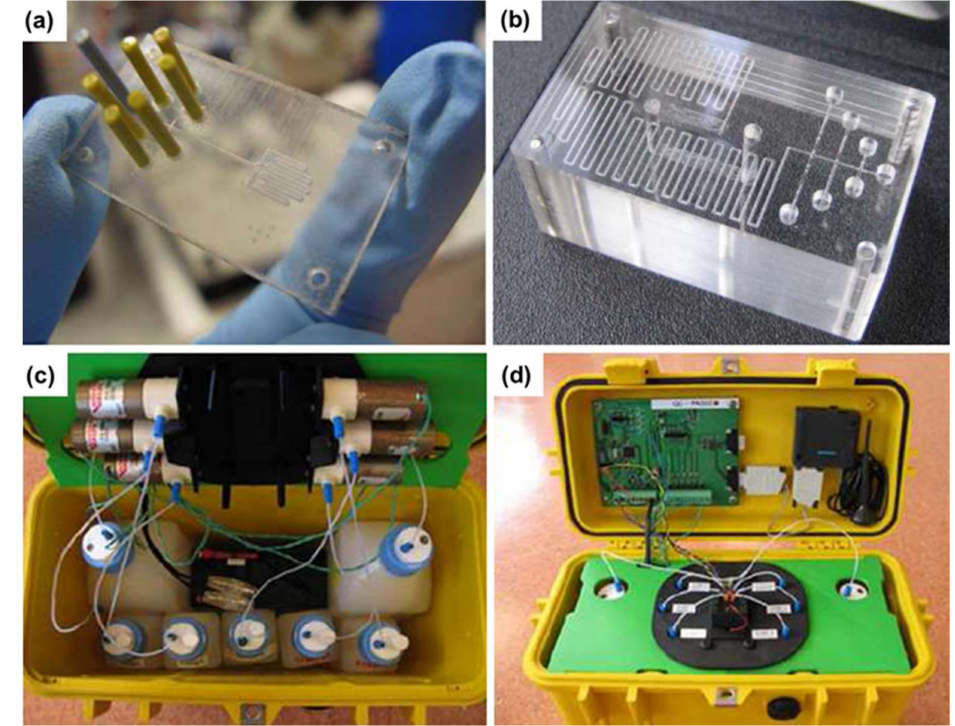
Figure 2. The optofluidic chips and assembled system used for phosphate detection. A high-sensitivity absorbance optical detection module is integrated with the optofluidic chip to monitor the colorimetric reaction of 20 µ L volume reagent and sample. ( a ) The physical photo of microfluidic chip is described in this section. It shows a curved channel on the right side and six inlets on the left side with one outlet [36]. ( b ) Another chip redesigned to mix the sample and reagent, and the area used to detect is substituted with a cylindrical optical cuvette [36]; ( c ) an integrated device with bottles and battery [37]; ( d ) top board and cover showing electronic board and GSM modulator